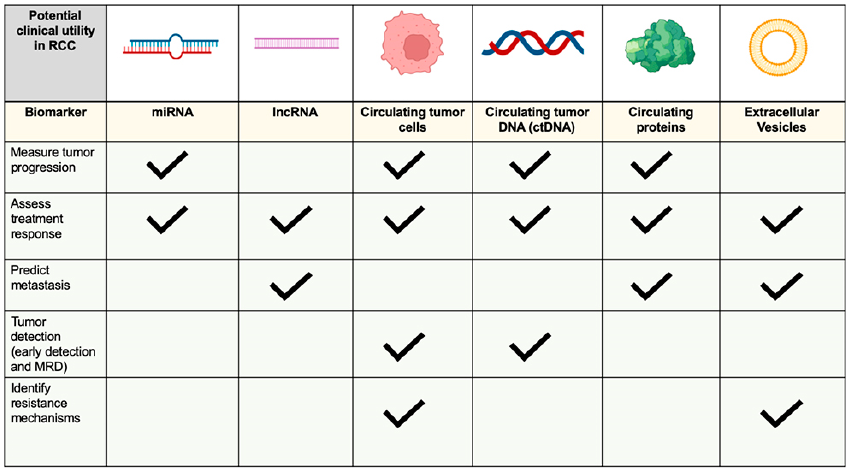
Figure 2. Circulating biomarkers and their potential clinical utility in the oncological management of mRCC patients.